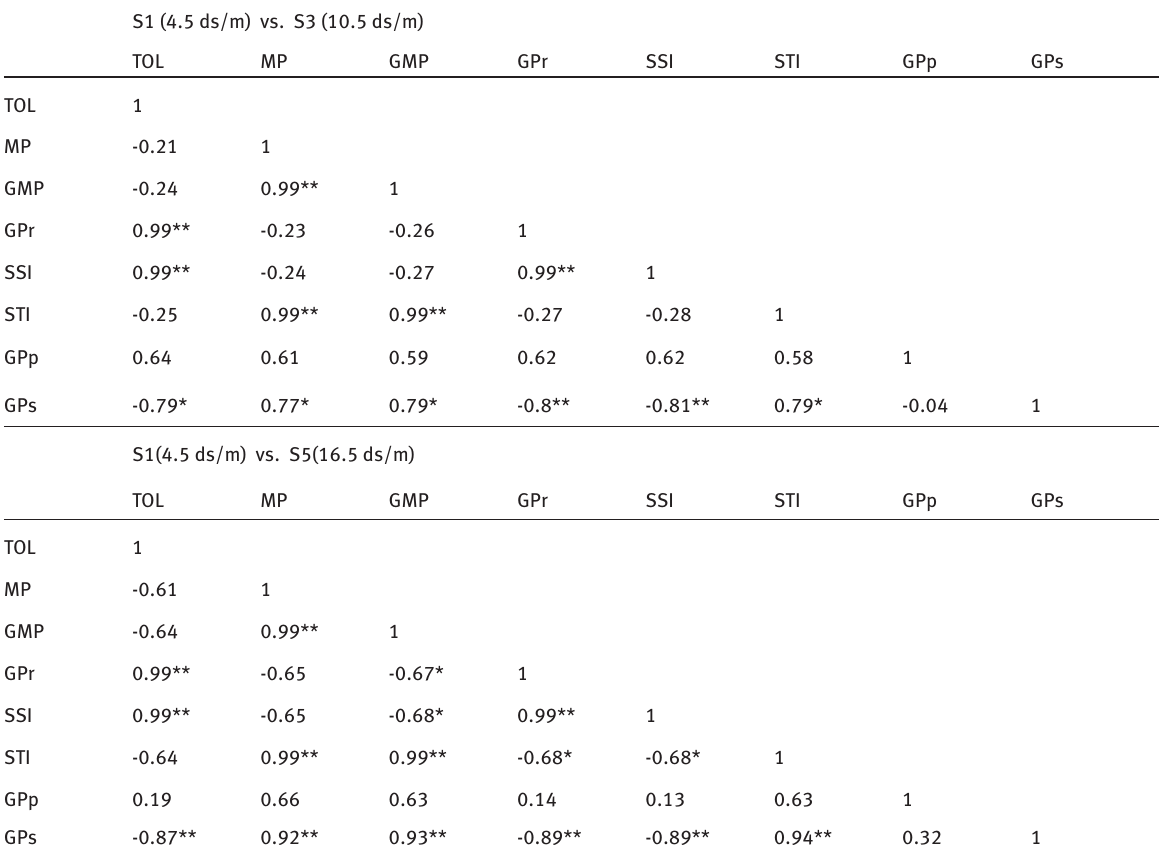
Table 5: Correlation coefficient of stress tolerance indices with GPp and